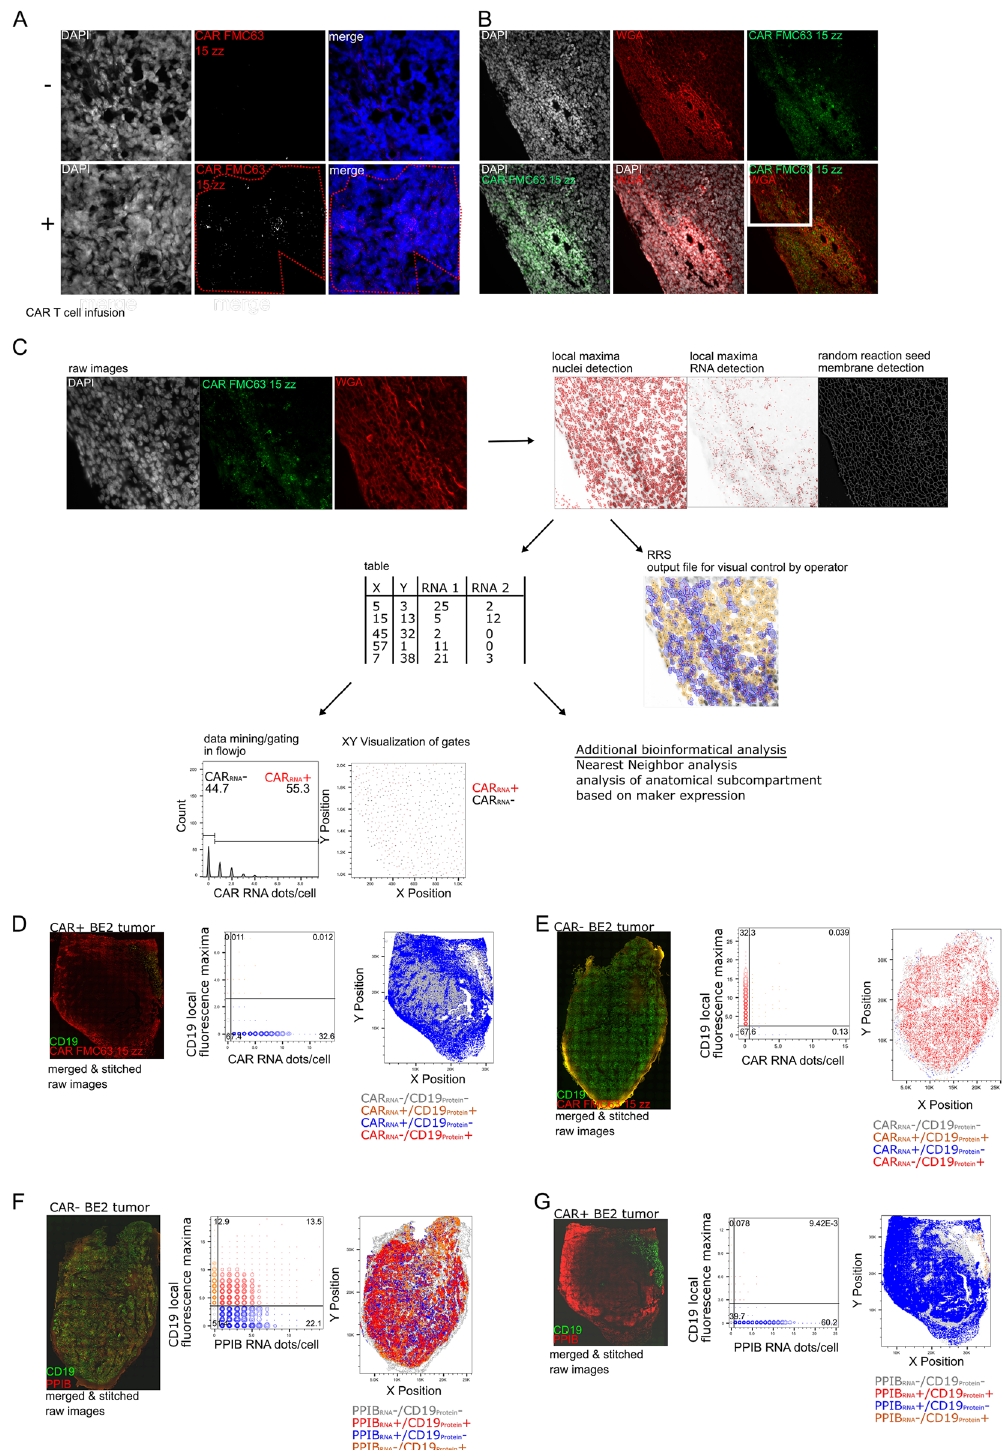
Figure 2. In situ detection of anti-CD19-CAR T cells in mouse xenografts of NSG mice after anti-CD19 CAR T cell infusion. FFPE-BE2 neuroblastoma xenografts with ectopic expression of truncated CD19 treated with anti-CD19 CAR T cell for 7 days or without CAR T cells was used for the CAR RNA FISH in situ validation. Staining of CAR+ and CAR− FFPE-BE2 tumor tissue sections with CAR FMC63 15zz probes (red). The red dotted line denotes an area that showed specific CAR RNA FISH staining ( A ). Staining of CAR+ BE2 tumor with CAR FMC63 15zz probes and Texas Red-conjugated wheat germ agglutinin improves cell segmentation ( B ). RRS analysis of multicolor raw images includes nuclei and CAR RNA detection as well RRS detection of plasma membrane staining. The algorithm generates a table internally containing the RNA dots/cell and the x–y position of every detected cell, which can be exported for data mining in Flowjo to assess and visualizedifferential RNA expression and locations of different cell types. These data can be further used for additional bioinformatical analysis. The example picture derives from the area framed in white in B ( C ). Whole tissue overview images show the distribution of the CAR RNA and CD19 IHC staining combined with WGA and DAPI (not shown) and the whole tissue RRS analysis of CAR+ (n = 3) ( D ) and CAR− (n = 3) ( E ) tumor